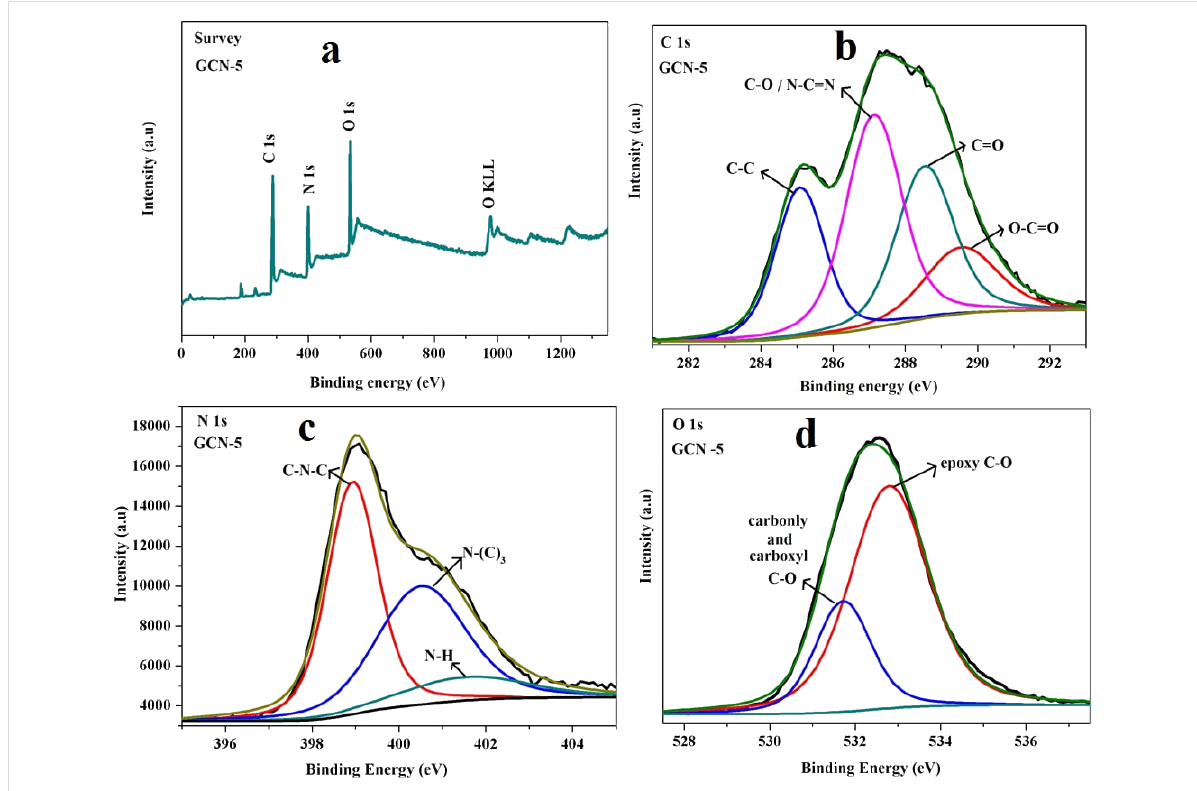
Figure 3: X-ray photoelectron spectroscopy analysis of the prepared GCN-5: a) survey spectrum, and high-resolution b) C 1s, c) N 1s and d) O 1s spectra.